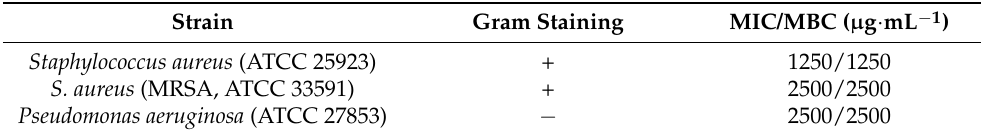
Table 3. The Minimum Inhibitory Concentration (MIC) and Minimum Bactericidal Concentration (MBC) of the lyophilized optimized aça í meal extract. Strain Gram Staining MIC/MBC ( µ g · mL − 1 ) Staphylococcus aureus (ATCC 25923) + 1250/1250 S. aureus (MRSA, ATCC 33591) + 2500/2500 Pseudomonas aeruginosa (ATCC 27853) −